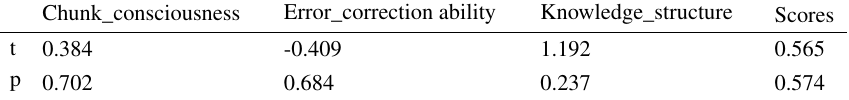
Table 1 Comparison of knowledge chunk abilities and scores before